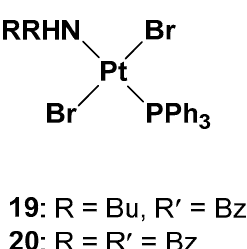
Figure 10. Pt(II) complexes 19 and 20